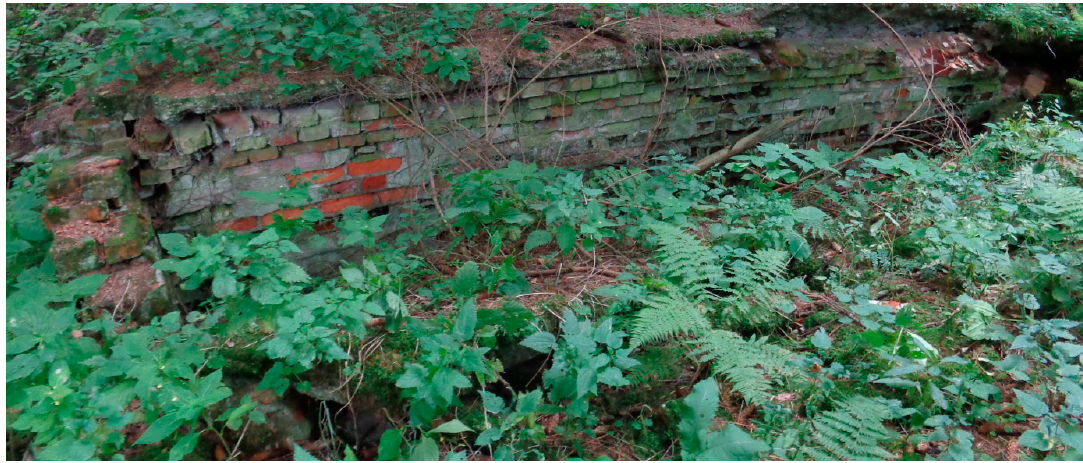
Figure 12. Remains of the barrack’s brick underpinning, former AL Säuferwasser camp; photo P. Lewandowski.